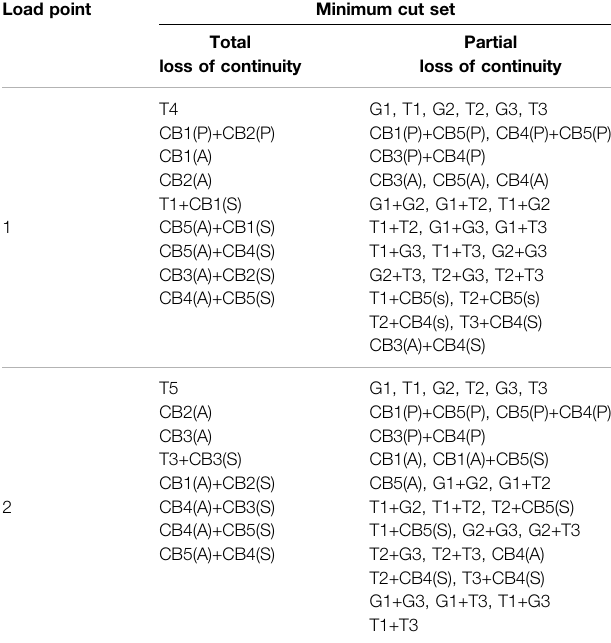
TABLE 4 | Minimum cut sets for load points 1 and 2.